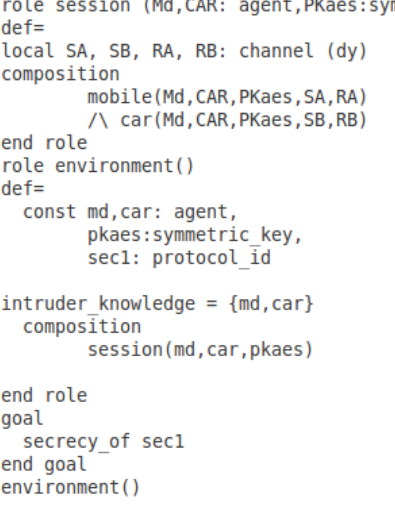
Figure 20. Session and environment in HLPSL in the offline phase.